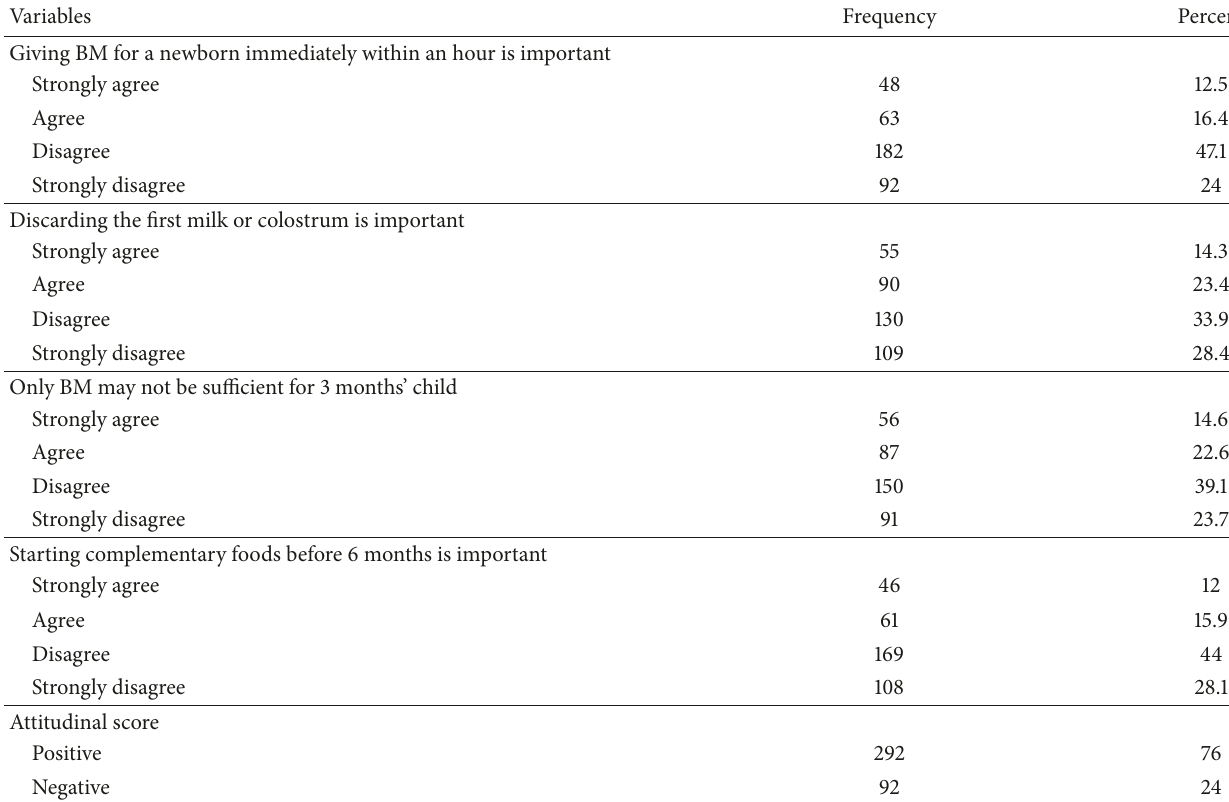
Table 3: Attitude of study participant mothers towards exclusive breast feeding (EBF) in Dabat Health Center, Northwest Ethiopia. 𝑛 = 384 . Variables